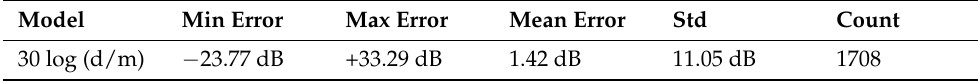
Table 1. Performance of the 868 MHz prediction